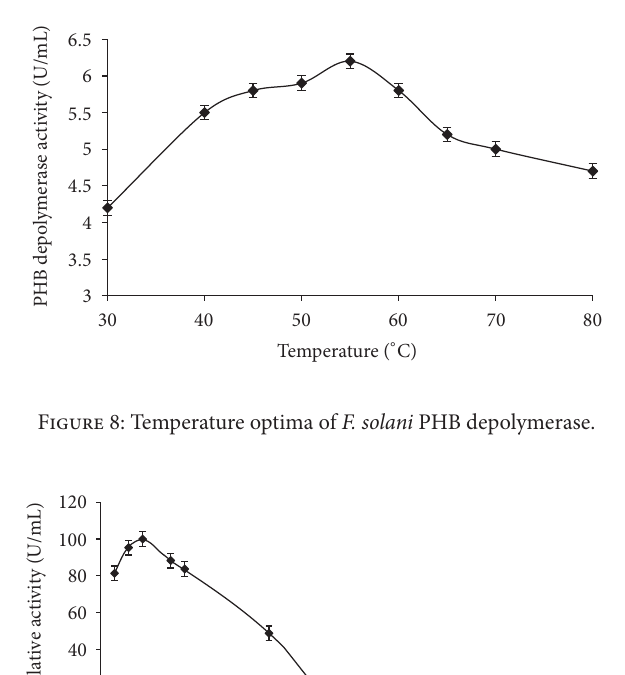
F 5: Glycoprotein staining of PHB depolymerase by PAS method. Standard molecular weight marker (Coomassie stained) (Lane 1)� puri�ed PHB depolymerase by ammonium sulphate precipitation (Lane 2), and affinity chromatography (Lane 3) aer PAS method.